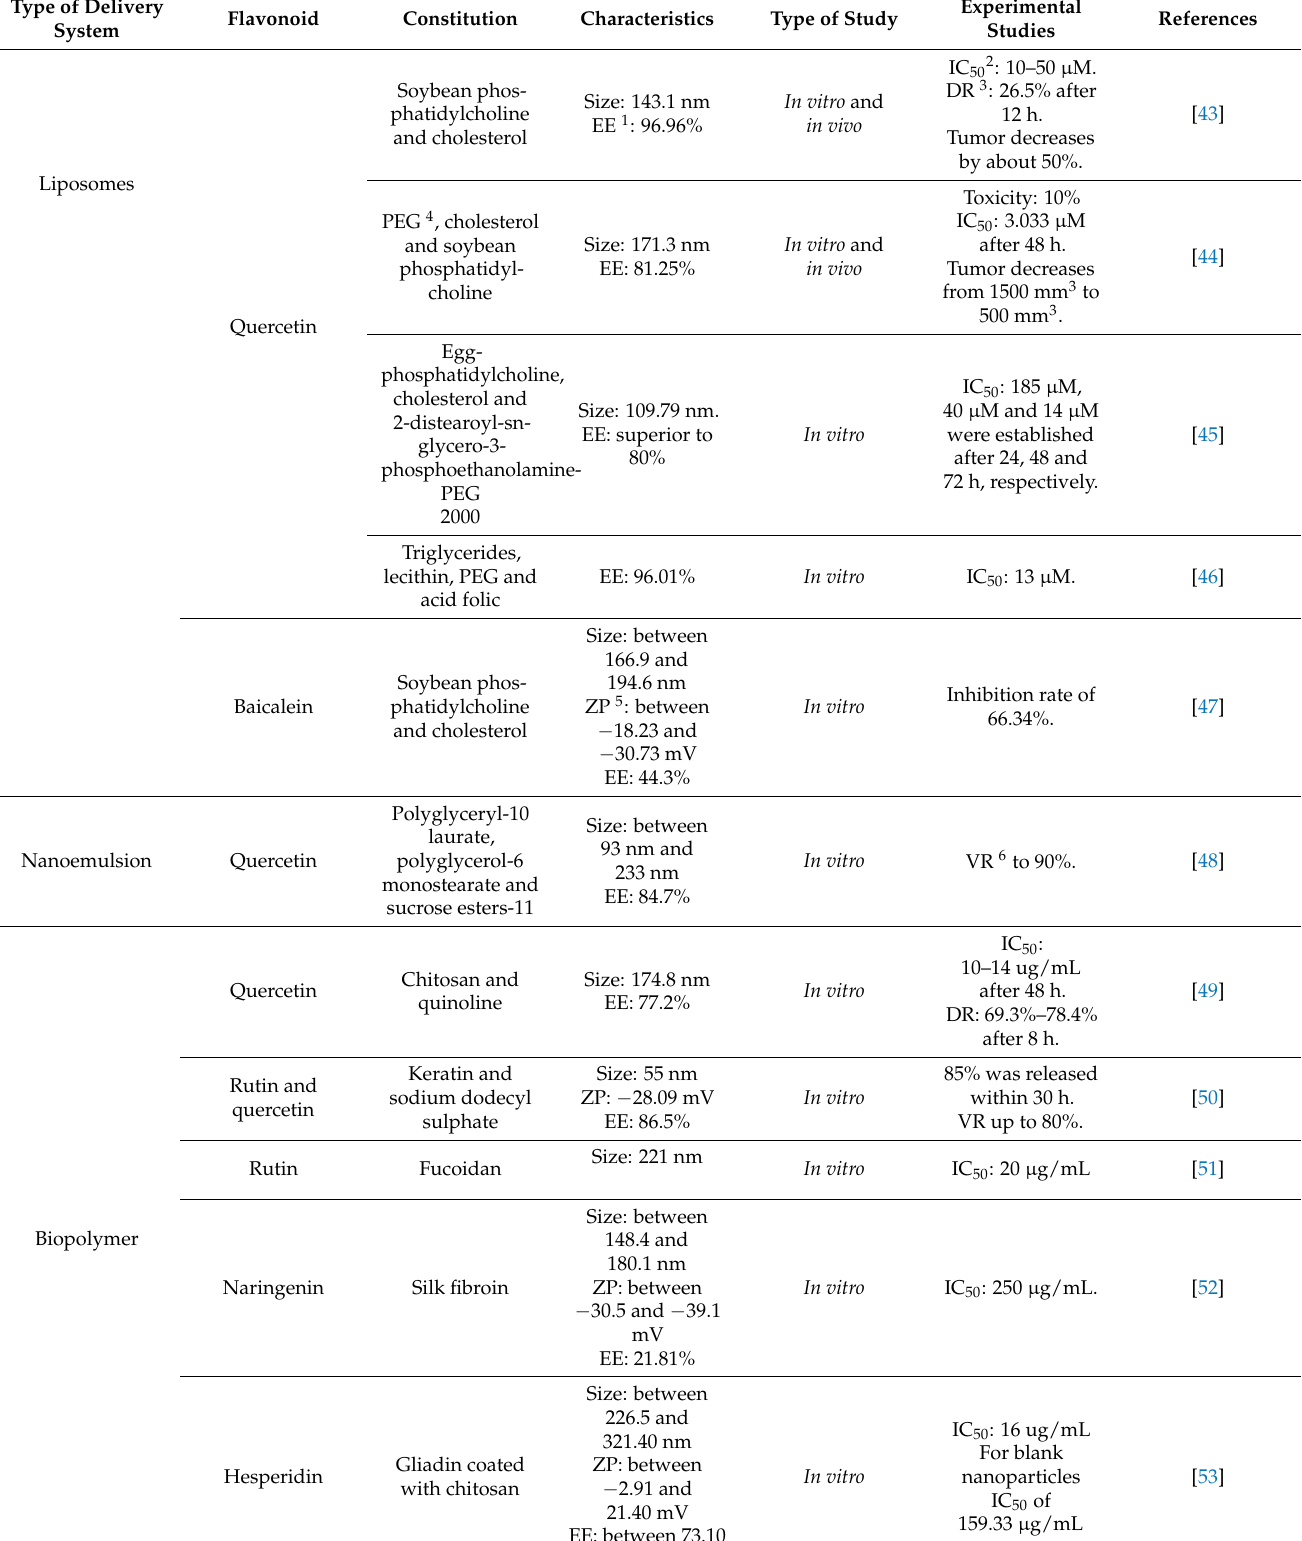
Table 1. List of delivery systems used in in vitro HeLa cells and in vivo U14 cervical